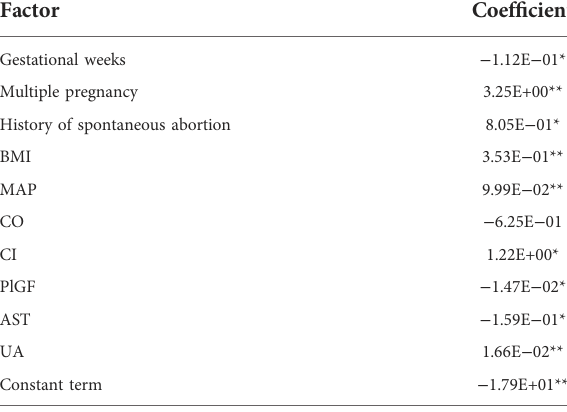
TABLE 13 Parameters of the stepwise regression dynamic prediction model for the early-onset preeclampsia. Factor Gestational weeks